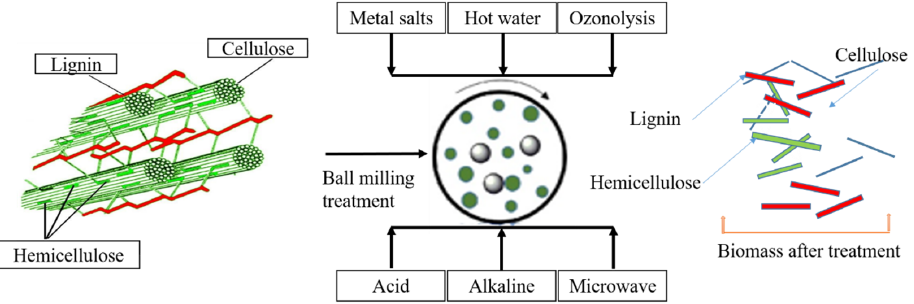
Figure 14. BM method coupled with other techniques to destroy the complex structure of lignocellulosic biomass. Recreated with permission from Ref. [26]. Copyrights © 2020 Elsevier B.V.